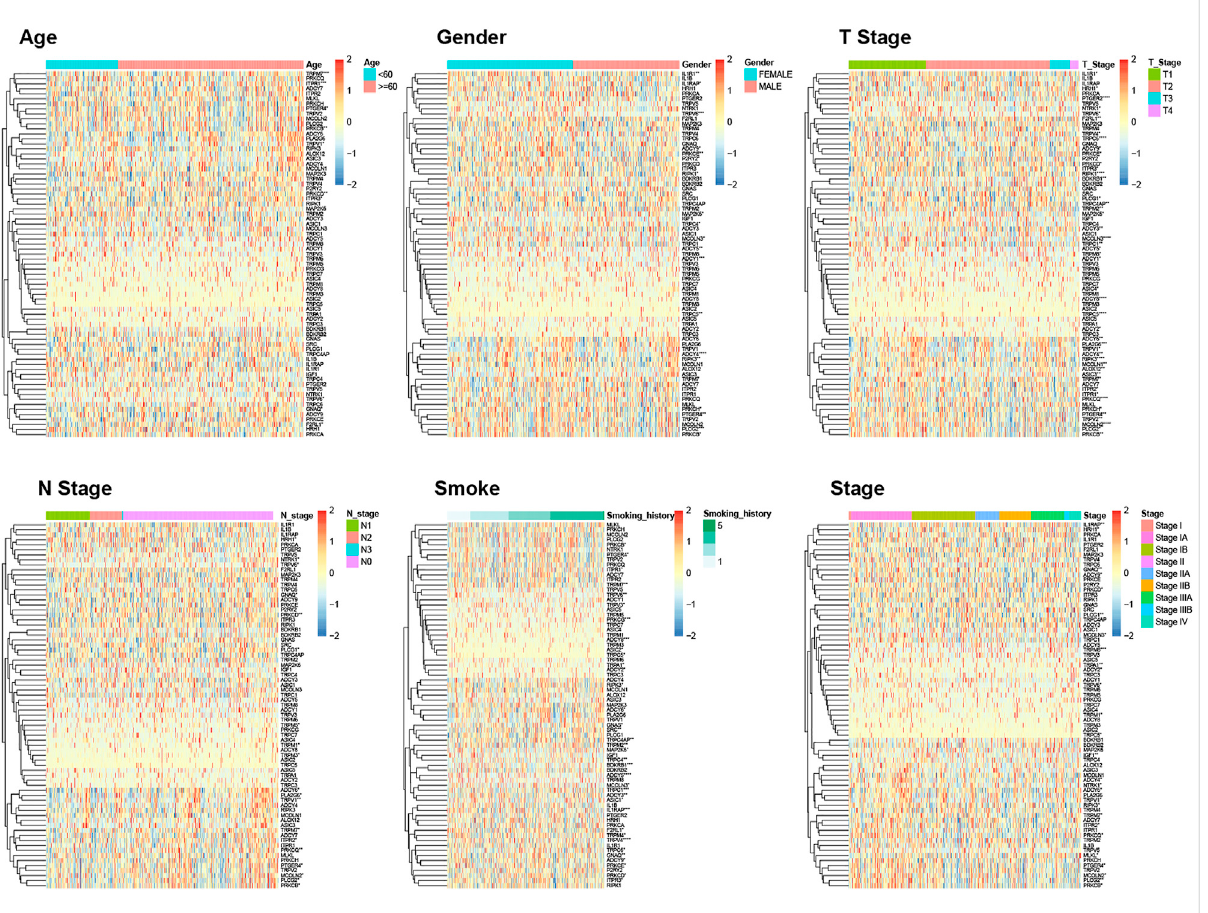
FIGURE 2 Differential heatmap of TRP-related genes in different clinical